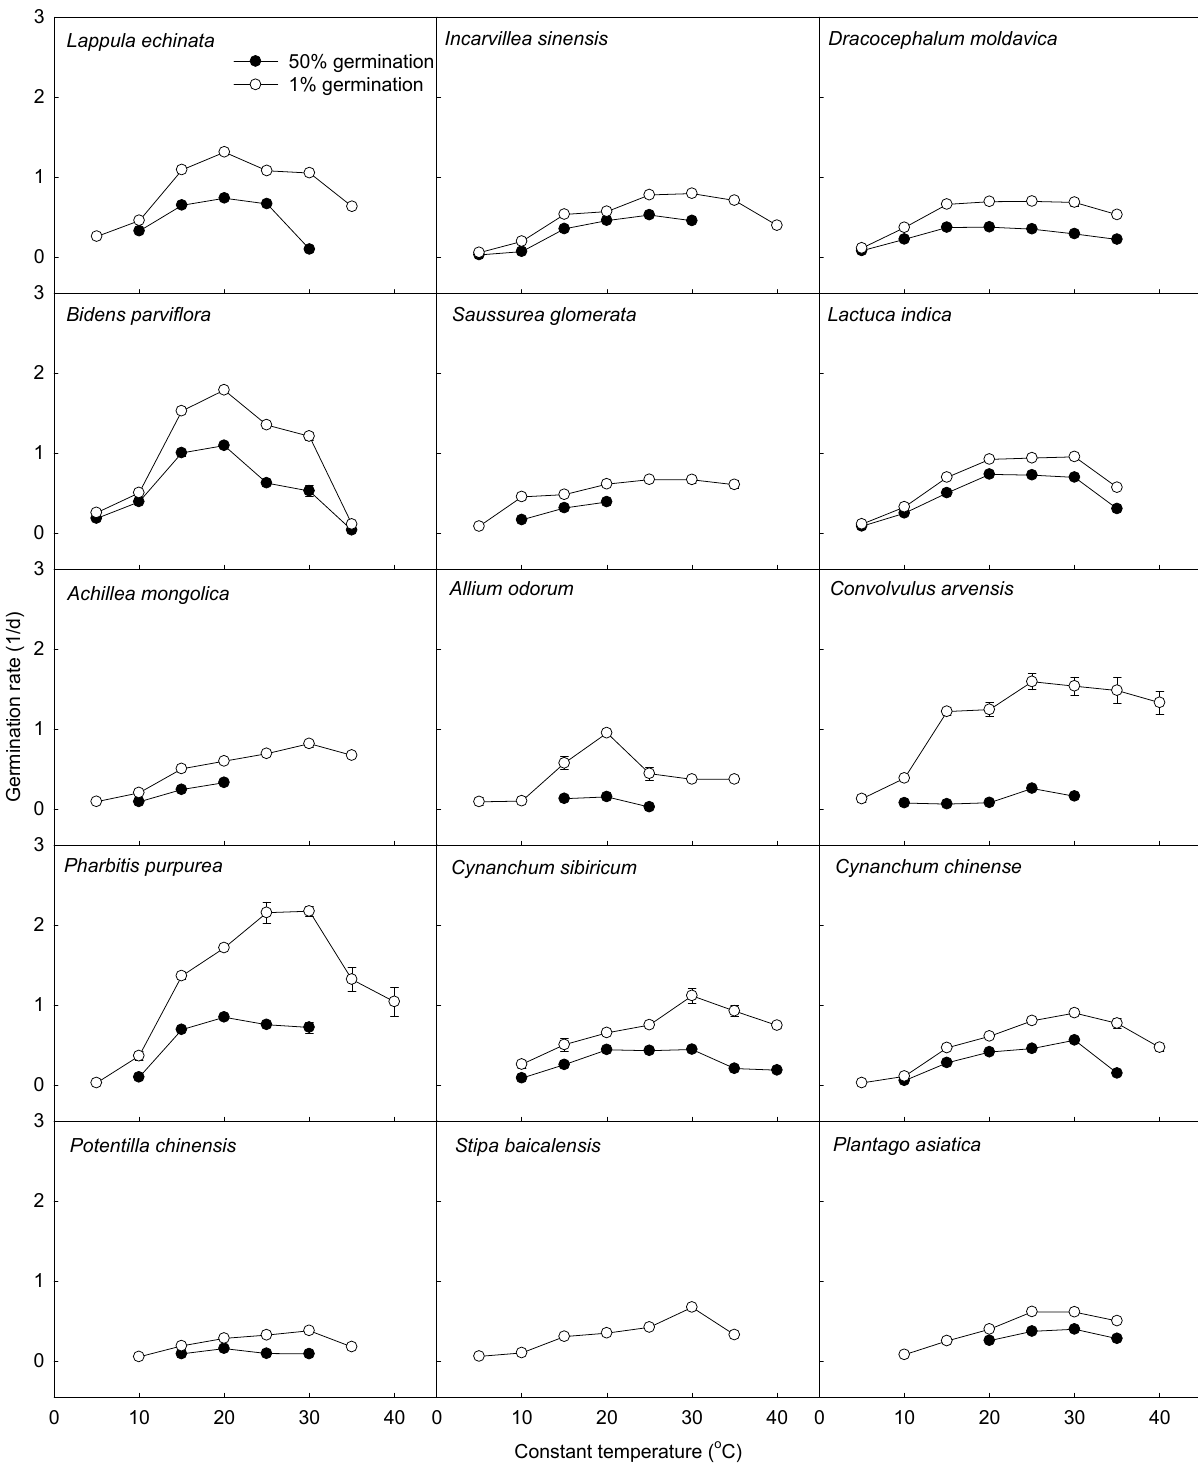
Figure 4. Germination rates of C 3 species for 1% ( ○ ) and 50% ( ● ) germination percentiles at a range of constant temperatures from 5 °C to 40 °C. Bars represent ±SE ( n =